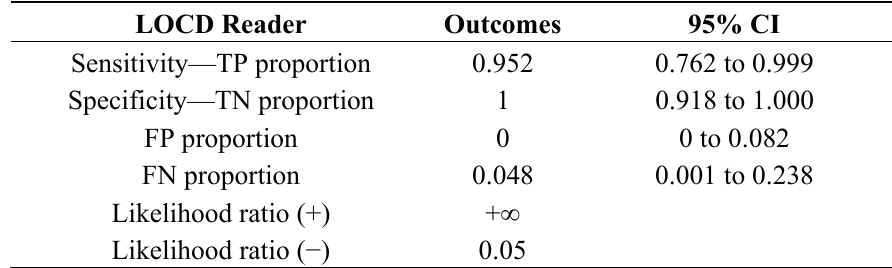
Table 2. LOCD ELISA detection platform clinical sensitivity and specificity (n = 64). (See Supplementary Materials for